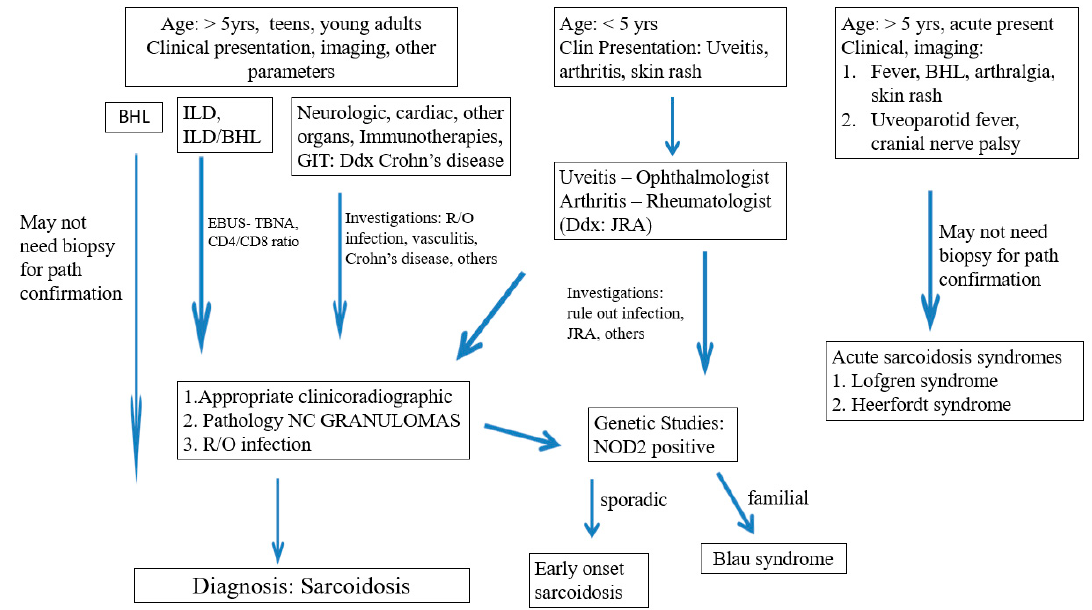
Figure 8. Paediatric Sarcoidosis: Diagnostic Considerations. Legends: BHL Bilateral hilar lymphadenopathy, ILD Interstitial lung disease, GIT gastrointestinal tract, EBUS-TBNA endoscopic bronchial ultrasound-transbronchial needle aspiration, NG non-necrotizing granulomas, JRA Juvenile rheumatoid arthritis, NOD2 Nucleotide binding oligomerization domain 2.